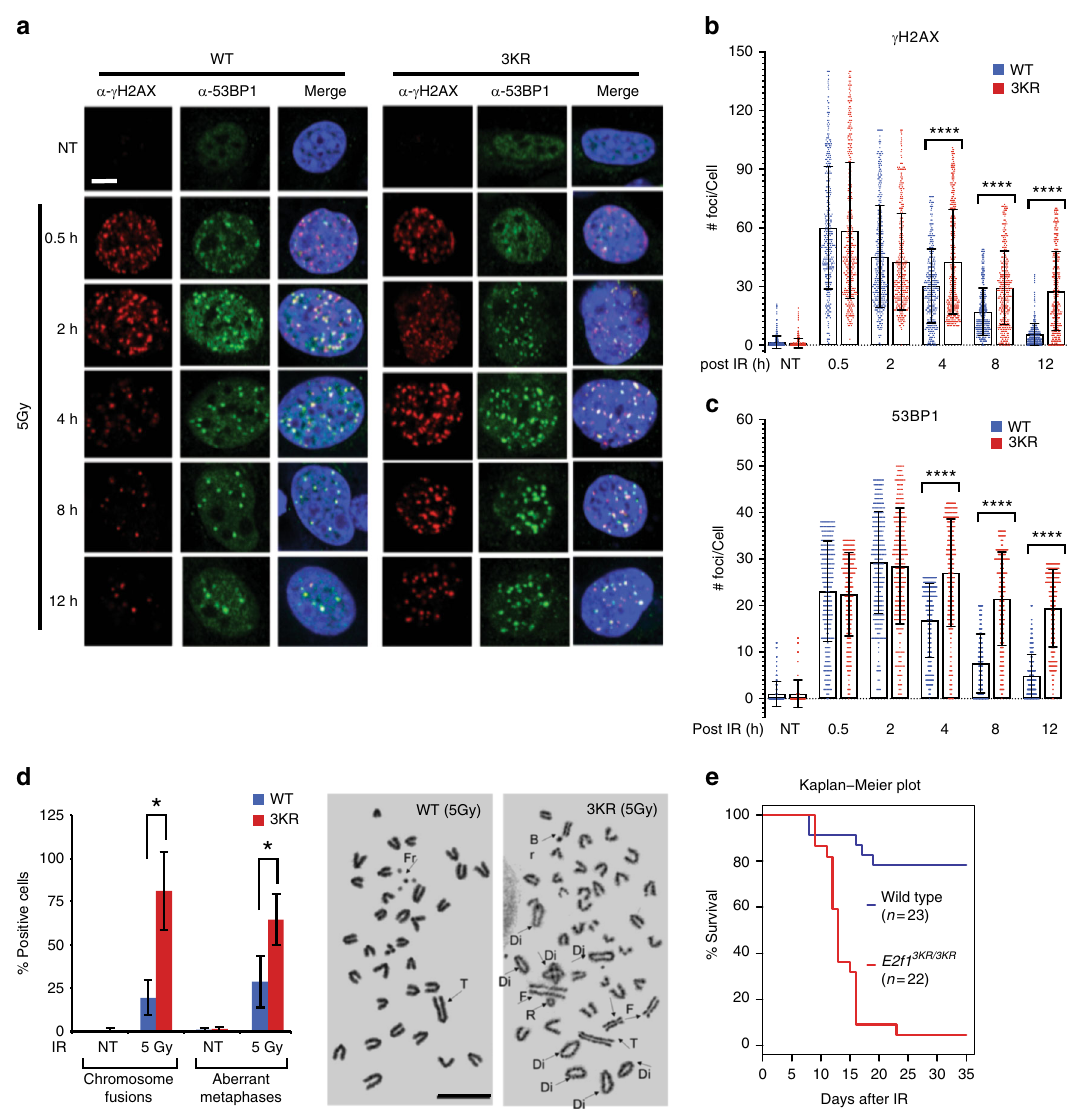
Fig. 7 The 3KR mutation causes defective DNA repair phenotypes. a Primary wild-type (WT) and E2f1 3KR/3KR (3KR) MEFs were mock-treated (NT) or treated with 5 Gy of IR and allowed to recover for the indicated times. Representative confocal microscopic images show the formation and disappearance of γ H2AX (red) and 53BP1 (green) foci and the merge with DAPI staining (blue) of nuclei. Bar, 10 μ m. b , c Quanti fi cation of γ H2AX foci ( b ) and 53BP1 foci treatment group. Graphs represent average ± SD of foci per cell. Overlaid scattered dot plot shows the distribution of foci. P values were calculated by unpaired Mann – Whitney U test. **** P < 0.0001 is highly signi fi cant. d Primary wild-type (WT) and E2f1 3KR/3KR (3KR) MEFs were mock-treated (NT)